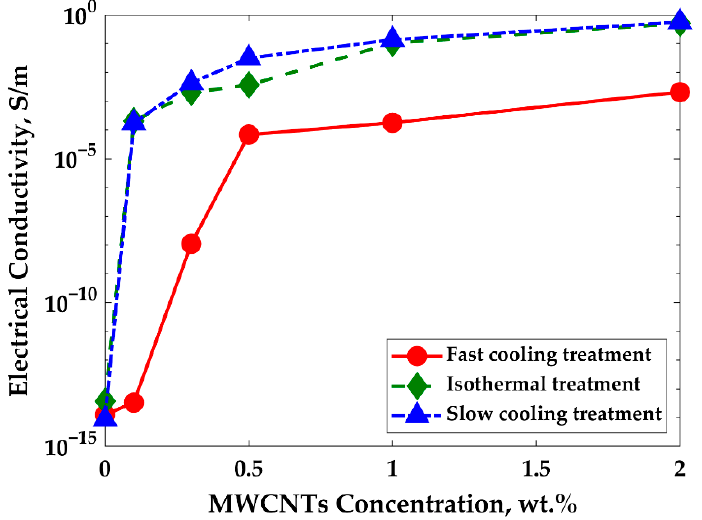
Figure 2. Effect of treatments on the electrical conductivity of PP/PS/MWCNTs composites as a function of MWCNTs concentration.